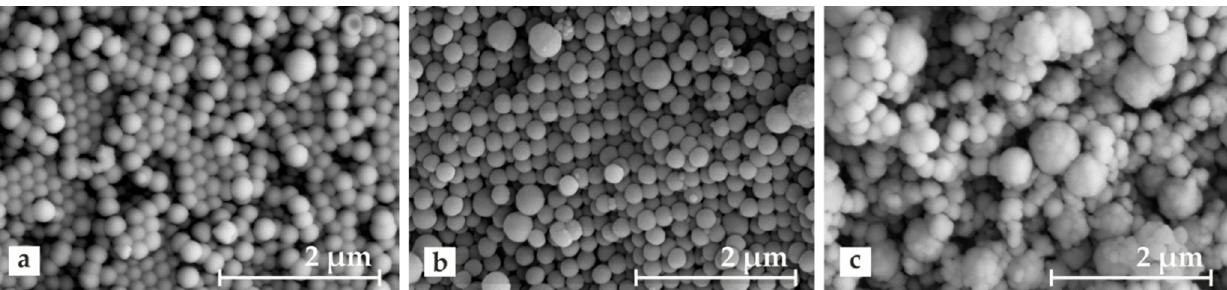
Figure 2. SEM images of calcined PS30_Si ( a ), PS30_Si_Co15_A ( b ) and PS30_Si_Co15_B ( c ).